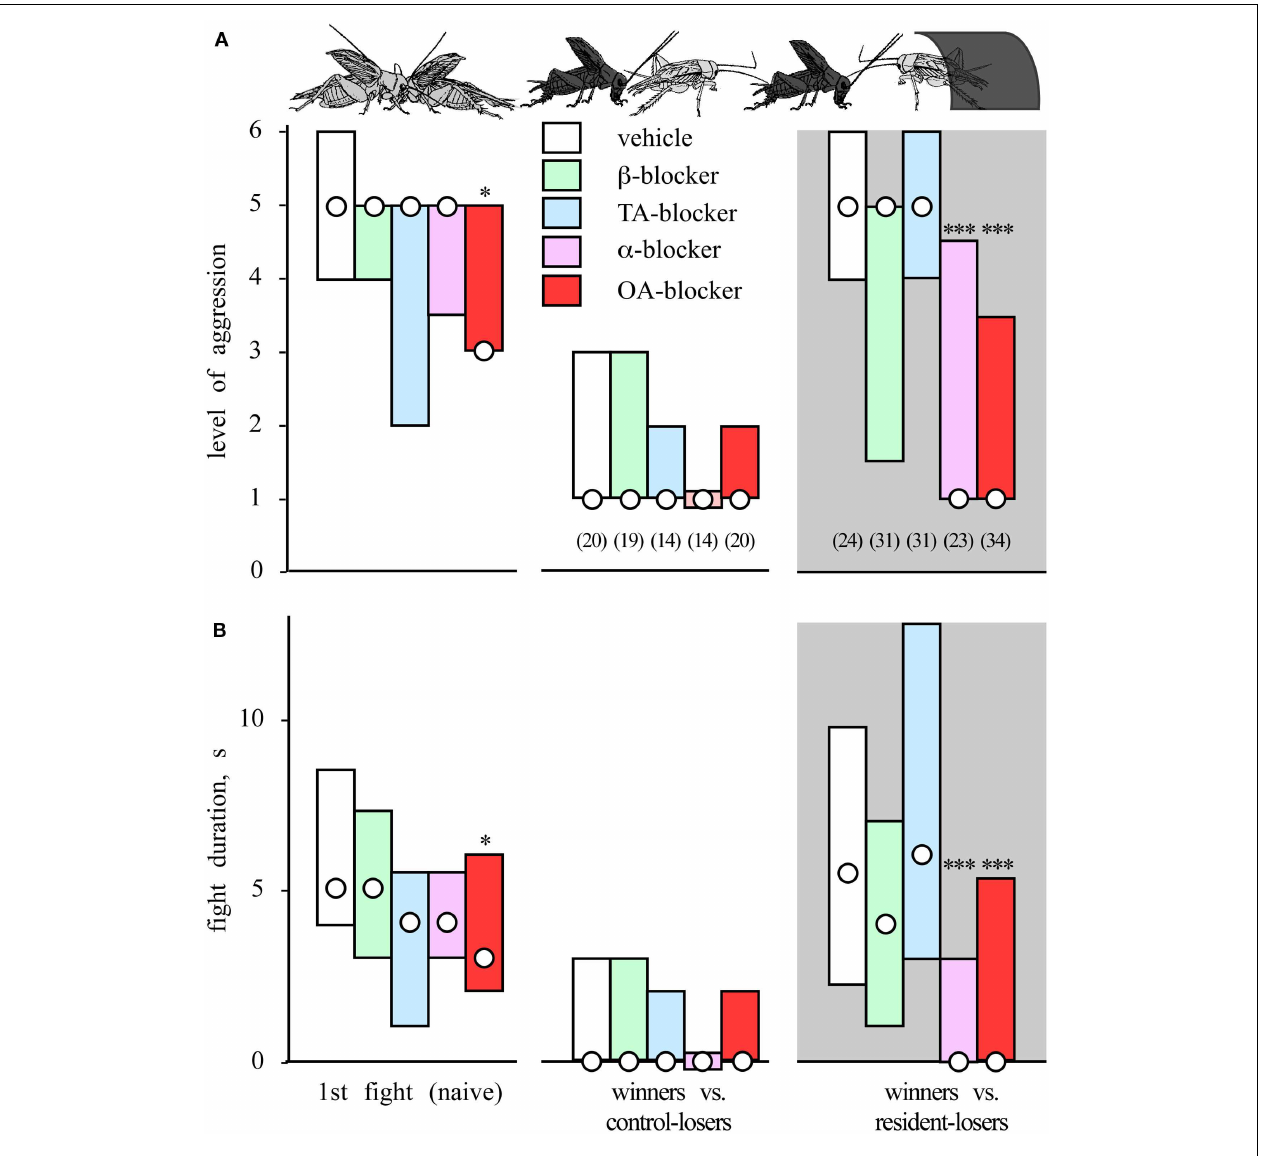
(naïve) and in a second contact 15min later before which the losers remained in the arena without a shelter (winners vs. control-losers) or occupied a shelter in the arena (winners vs. resident-losers, gray background).The number of contests evaluated n is given in parenthesis beneath each column, excepting initial fight, which is pooled. Asterisks denote statistically significant differences (Mann–Whitney U -test *, **, ***: p < 0.05, 0.01, 0.001 respectively; adopted from Rillich et al.,